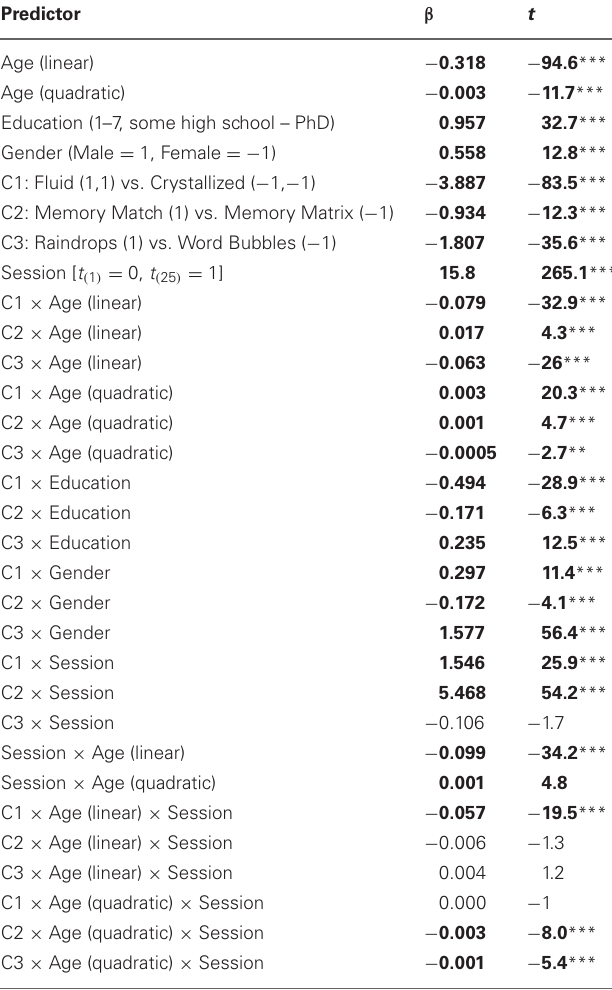
Table 2 | Coefficients and t -statistics for age and learning mixed effects